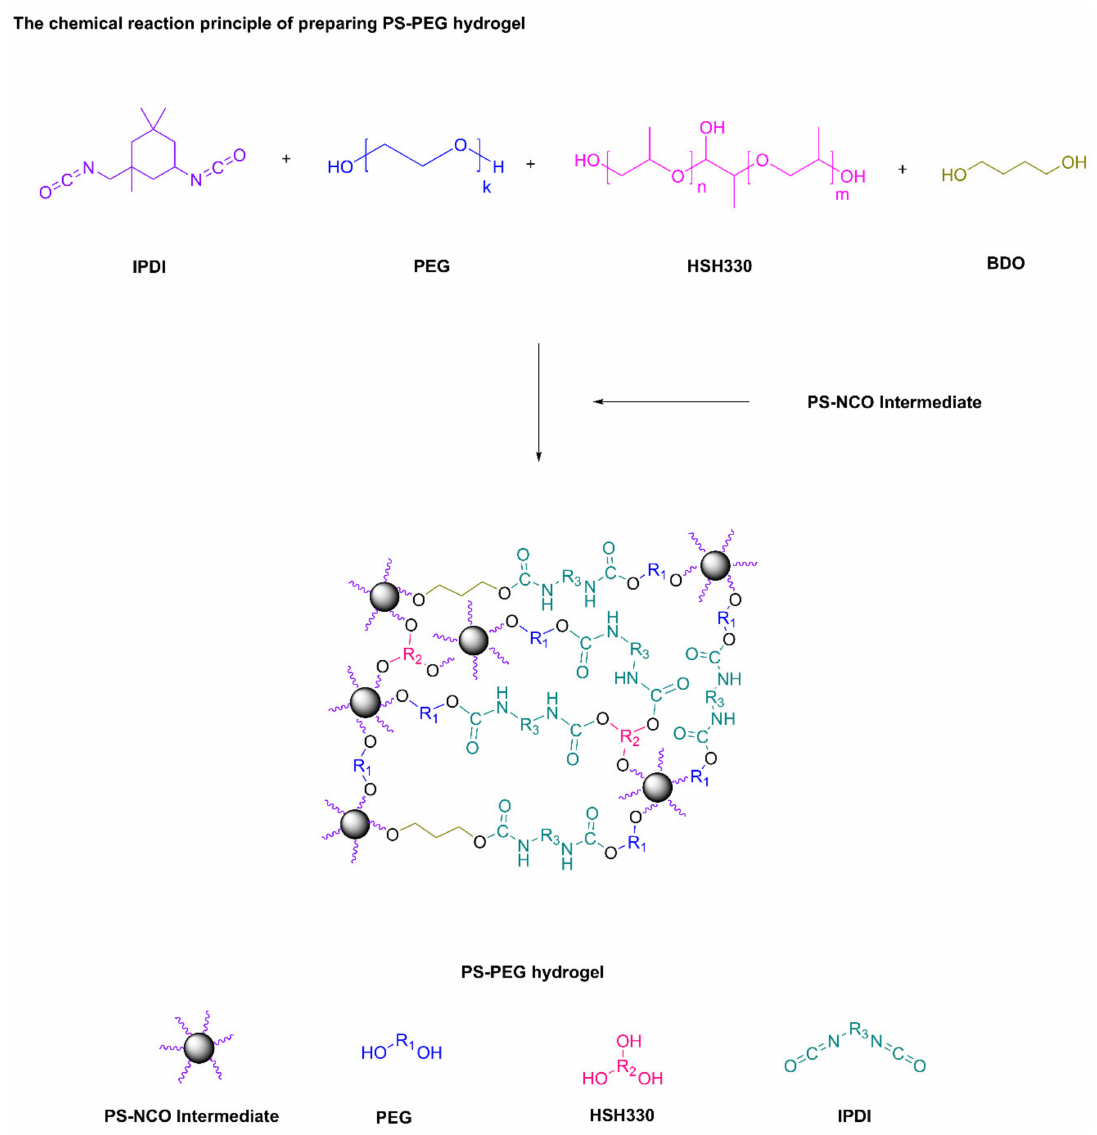
Figure 3. Chemical reaction principle of preparing PS-PEG